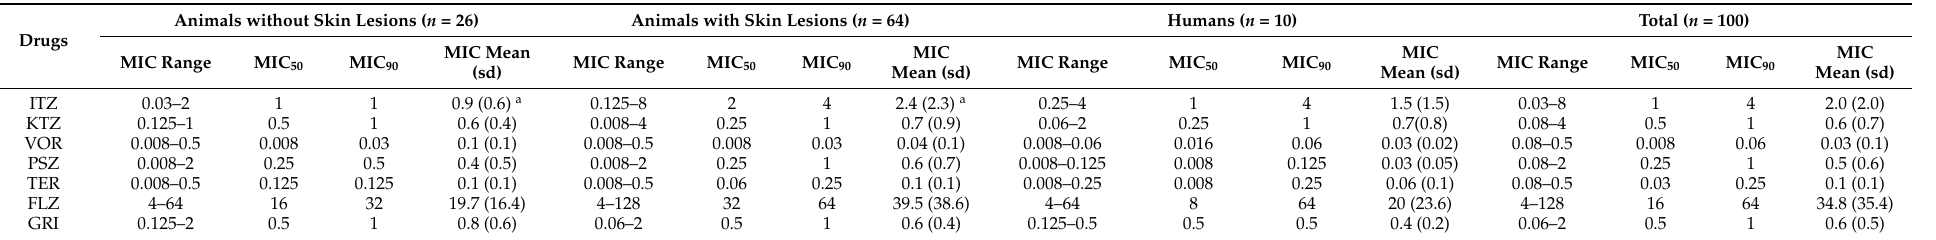
Table 2. Itraconazole (ITZ), ketoconazole (KTZ), voriconazole (VOR), posaconazole (PSZ), terbinafine (TER), fluconazole (FLZ) and griseofulvin (GRI) MIC data ( µ g/mL) of Microspo- rum canis strains from humans with tinea capitis and animals with and without skin